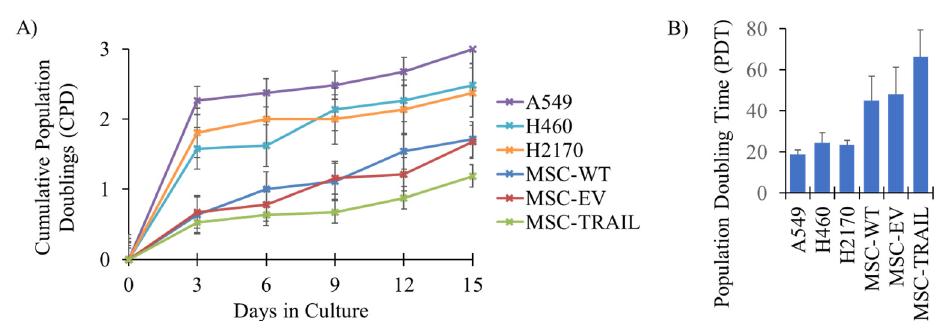
Figure 1. The cumulative population doublings (CPD) and population doubling time (PDT) of NSCLC (A549, H460 and H2170) and MSCs ((MSC-WT (wild-type), MSC-EV (empty vector) and MSC-TRAIL). Cultured cells were harvested every 72 h and their CPD and PDT were calculated. ( A ) CPD presented in the graph indicates the proliferation rate of each cell line at different days in culture. ( B ) Based on the CPD, the population doubling time (PDT) was calculated in hours for each of the cell lines.